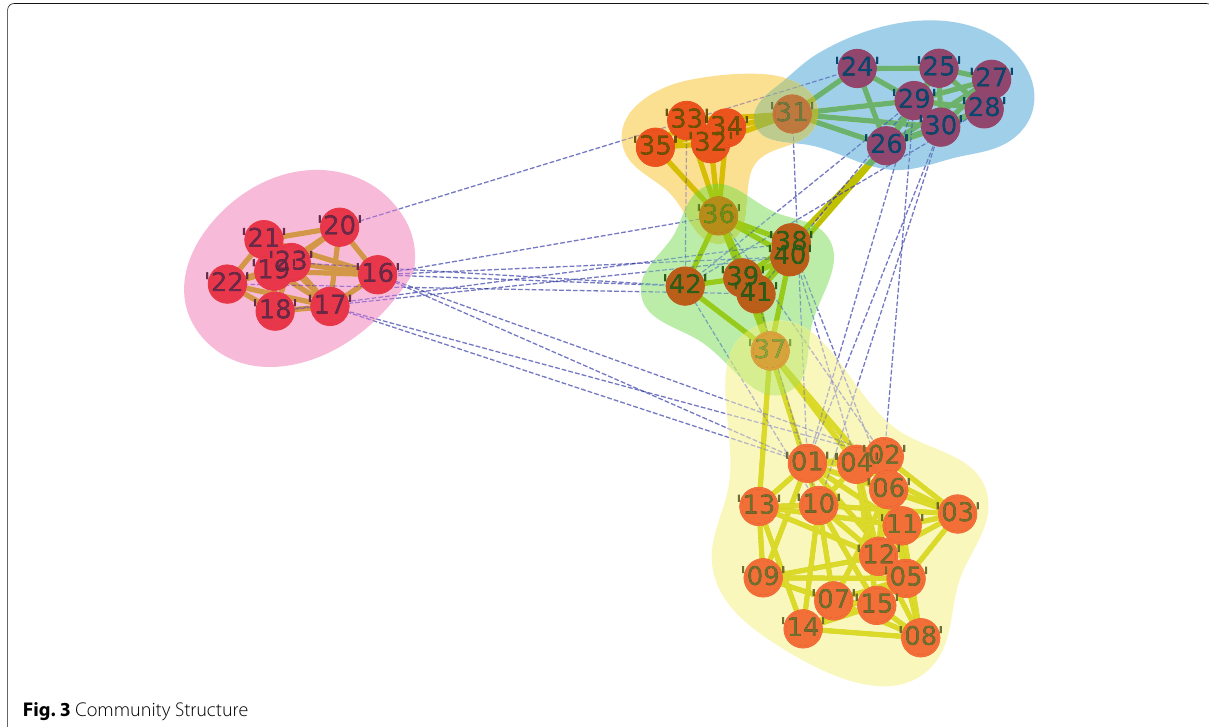
randomly divided into three, four, and five data-chains.